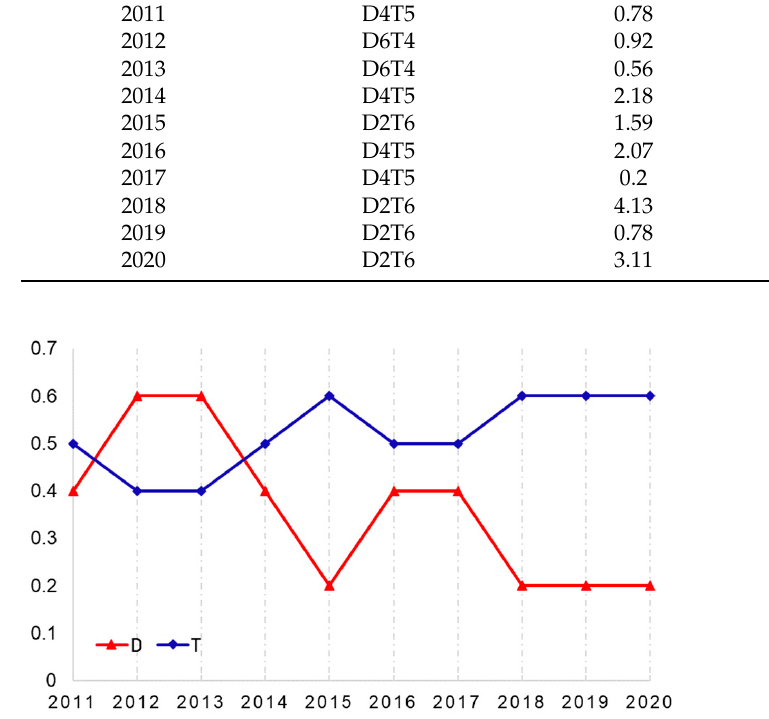
Figure 8. Modelled irradiation for a geographic area with default model (D3T5) and calibrated models. The complexity involved in calibrating the ArcGIS model refers to the fact that one measured value is used for a whole geographic area, be it measurements from the closest ground station or a central location. In addition, the only atmospheric parameters which